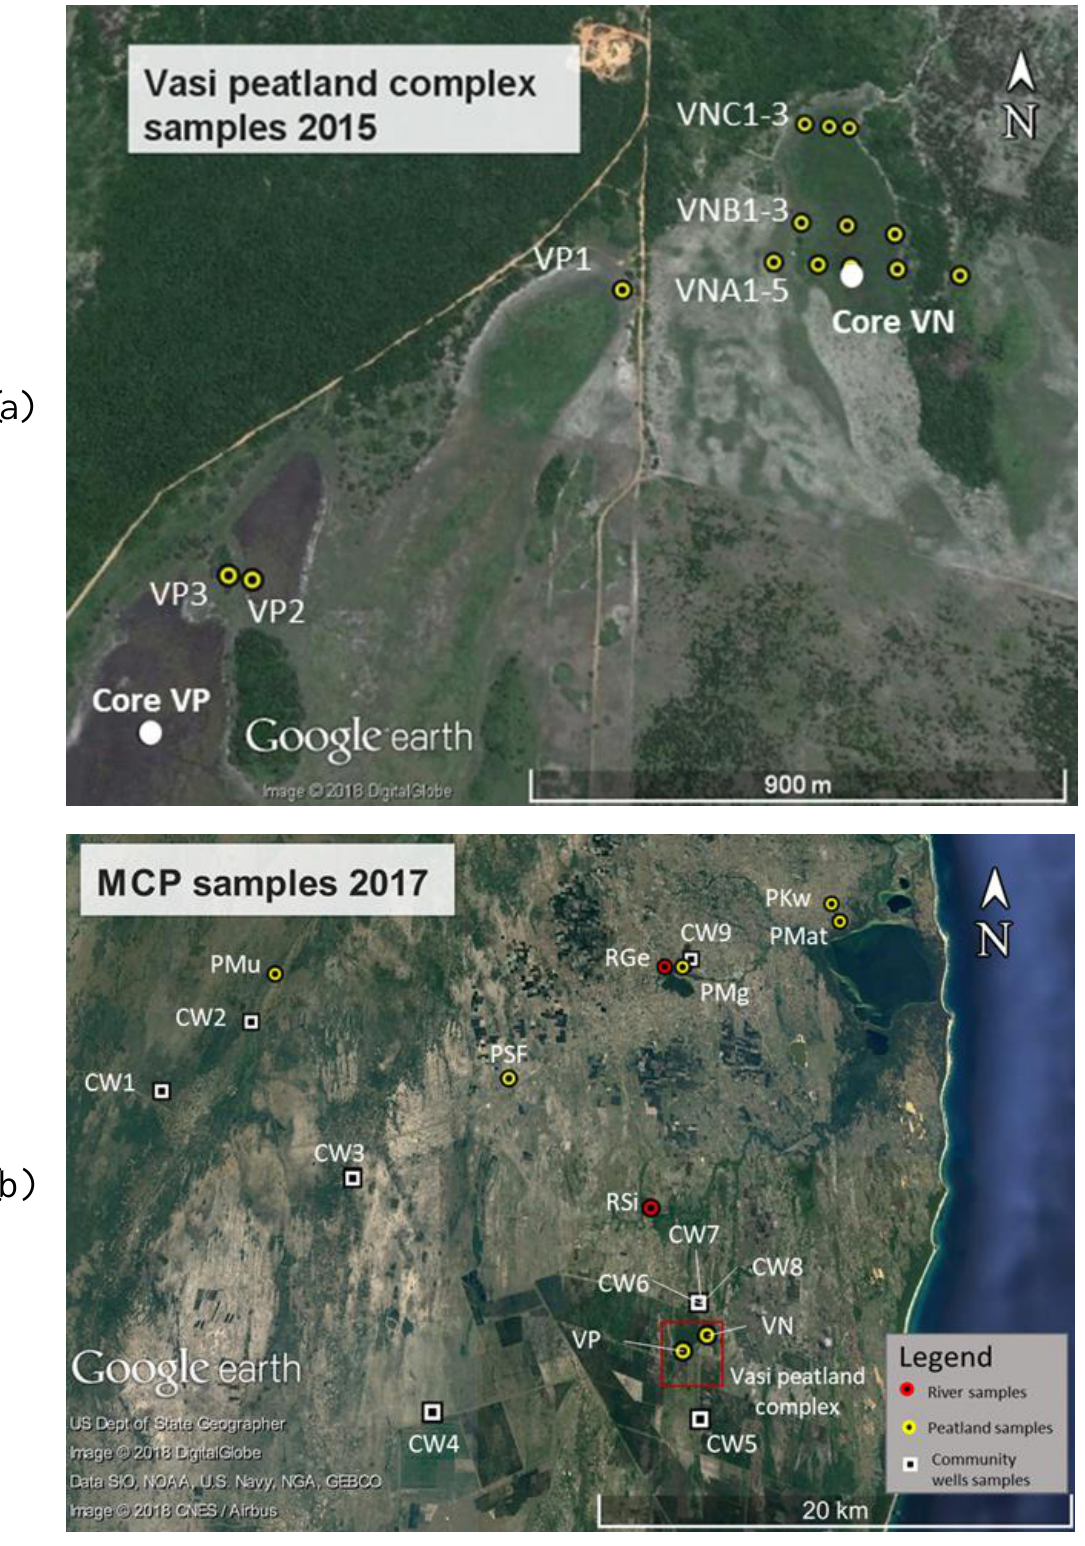
Figure 2. (a) Sampling points (spring 2015) within the Vasi peatland complex (Vasi Pan and Vasi-North) where groundwater tube nests (dipwells and piezometers) were measured and sampled. The white dots indicate the locations of the cores for 14 C dating and stratigraphy description. (b) Sampling points in northern Maputaland (MCP) during autumn 2017 from (i) river samples: RSi = Siyadla river, RGe = Gezisa river; (ii) peatlands: PMu = Muzi, PSF = Subsistence farming, VP = Vasi Pan, VN = Vasi North, PMg = Manguzi forest spring, PKw = KwaMbonambe, PMat = Matitimani; and (iii) community wells